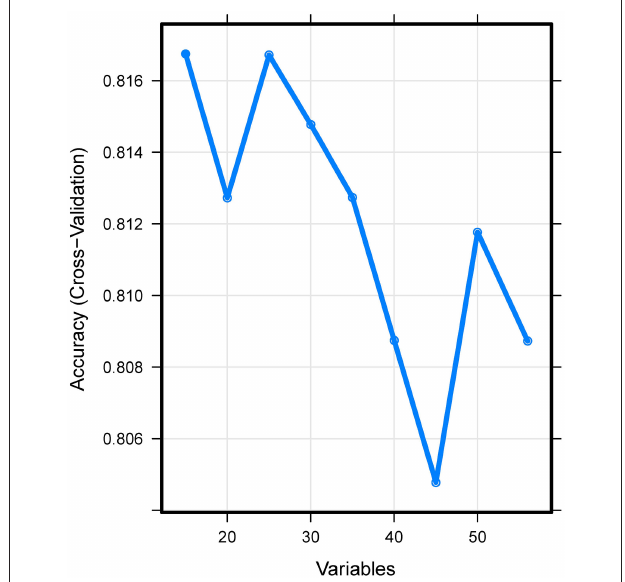
FIGURE 2 | Association between the number of variables allowed to be considered at each split and the prediction accuracy in the REF algorithm. REF, recursive feature elimination.